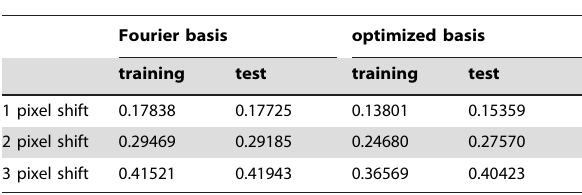
Table 1. Control for overfitting.